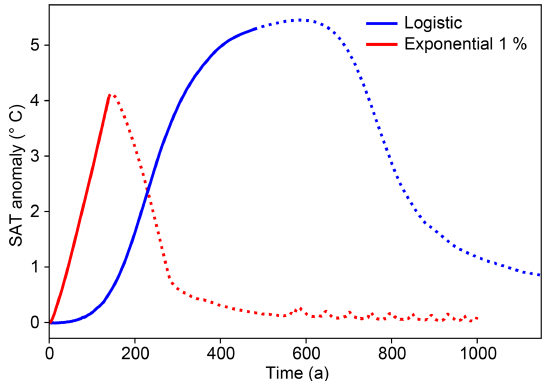
Figure 12. Evolution of global SAT anomaly during 4 × CO 2 1%- up, 1%-down and mirrored logistic experiments. Solid lines are the increasing CO 2 phase of the simulation and dotted lines are the at- mospheric CO 2 removal phase of the